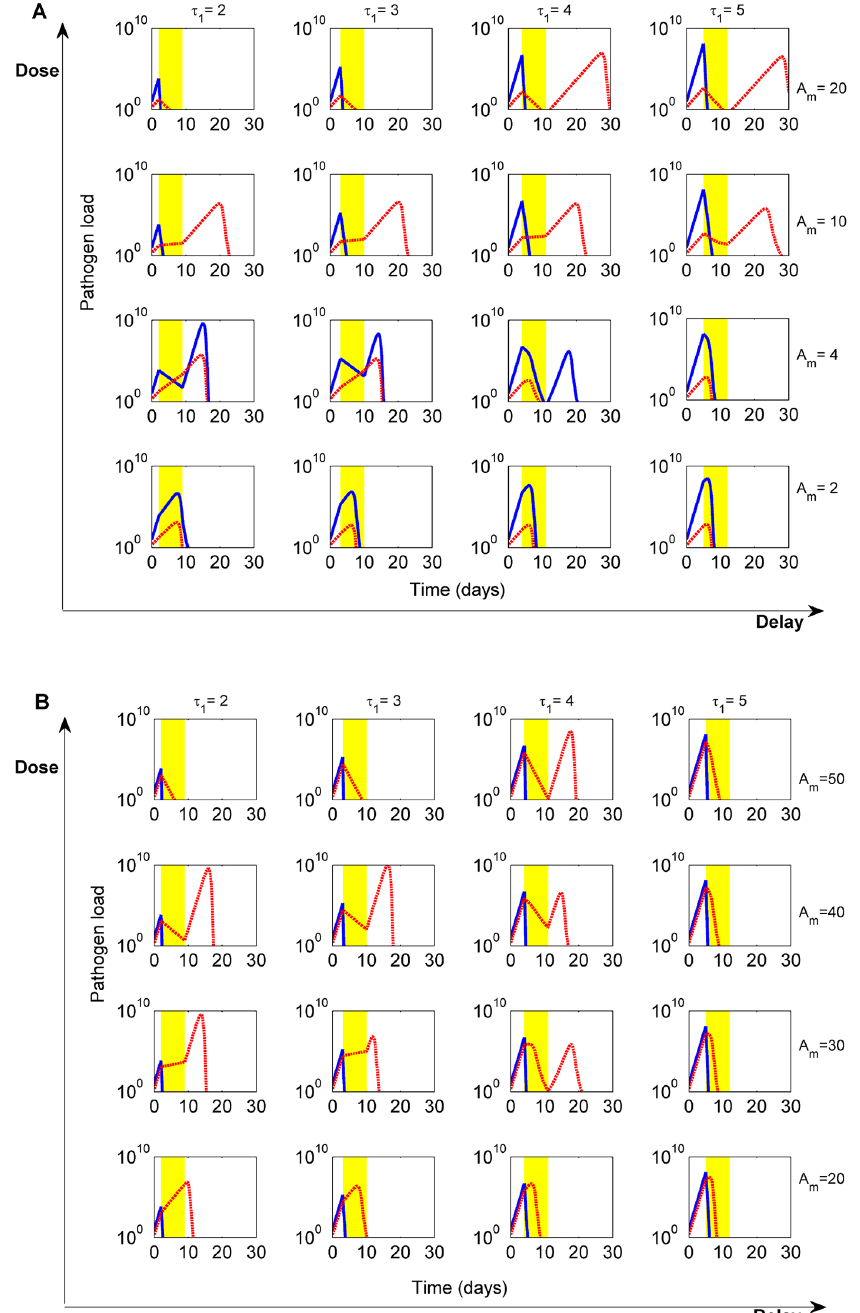
Fig 2. Dose-delay interaction during classical treatment with fixed dose and duration. Pathogen dynamics for the sensitive (blue) and resistant sub-population (red dashed line) are shown across different parameter combinations. A) High cost of resistance, c = 2.2. B) Low cost of resistance c = 0.1. Parameters as in Table 1, ( r 0 = 3.3) with treatment duration set to 7 days. Varying the cost of resistance, from A to B, shifts to higher values the range of critical doses that promote selection of resistance, from doses in [3.3, 11] to [3.3, 32]. However, we again observe an effect of bacterial clearance via synergistic interaction between drug and host immunity, when moderate doses are applied at appropriate times over the course of infection (here at τ 1 = 4 days). All scenarios depicted achieved infection clearance ( B < B ext ) by 30 days, except in A) scenarios: τ τ 1 = 4, 5, A m = 20 and 1 = 5, A m = 10, where clearance occurred by 30.1, 31.2 and 30.6 days respectively. The minimum time to clearance is observed for smallest delay and highest dose in both A) and B), at 7.8 and 7.2 days post